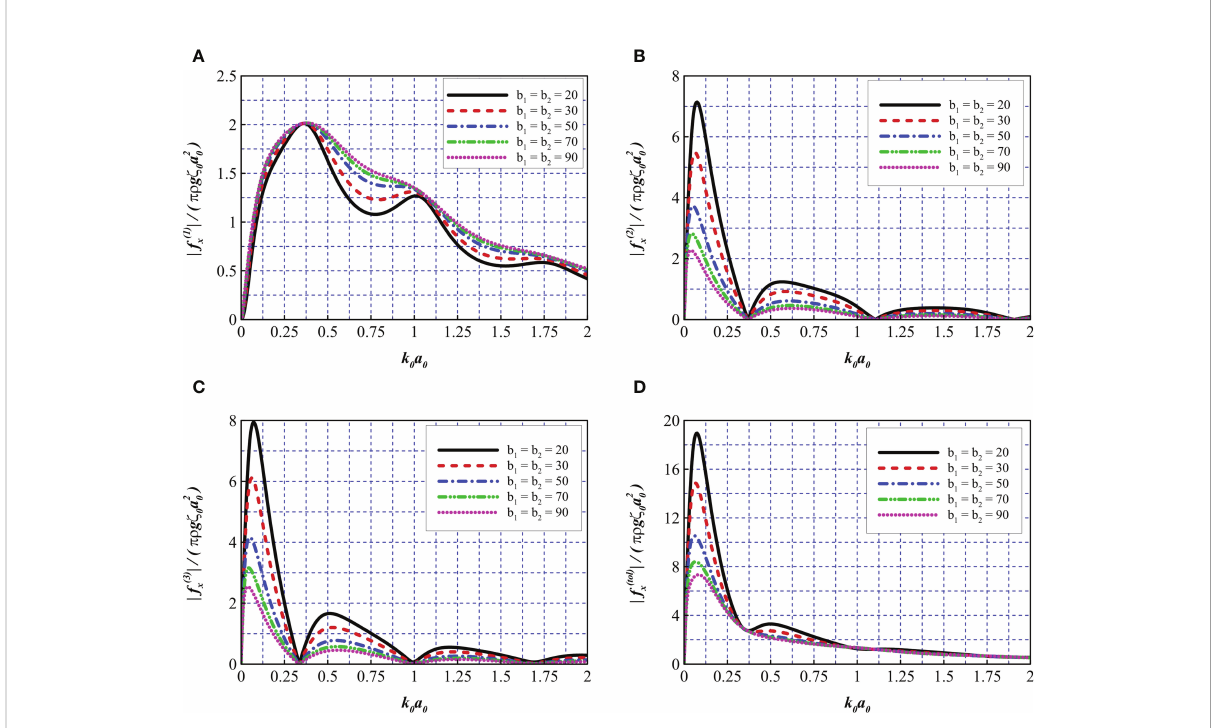
FIGURE 12 Comparison of wave force for different total porosity parameters. (A) j f (1) x j = ( pr g z 0 a 2 0 ), (B) j f (2) x j = ( pr g z 0 a 2 0 ), (C) j f (3) x j = ( pr g z 0 a 2 0 ), and (D) j f (tol) x j = ( pr g z 0 a 2 0